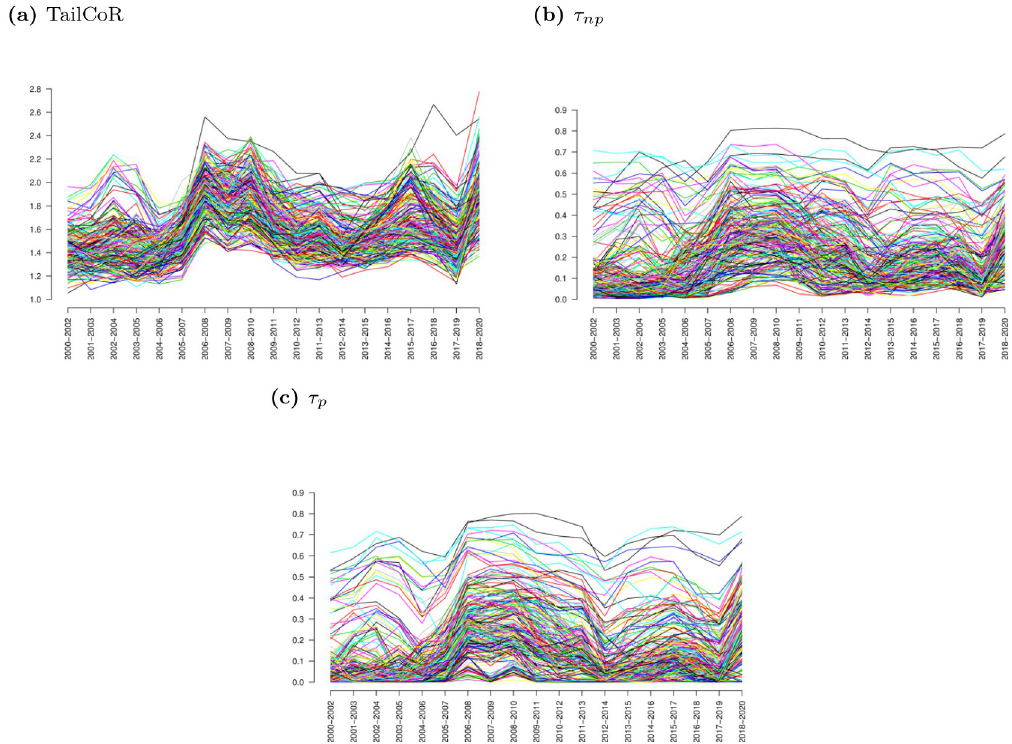
Fig 10. TailCoR and tail dependence coefficients. Panel (a) shows the evolution of TailCoR for all pairs of market indexes, while panels (b) and (c) show the non-parametric and parametric tail dependence